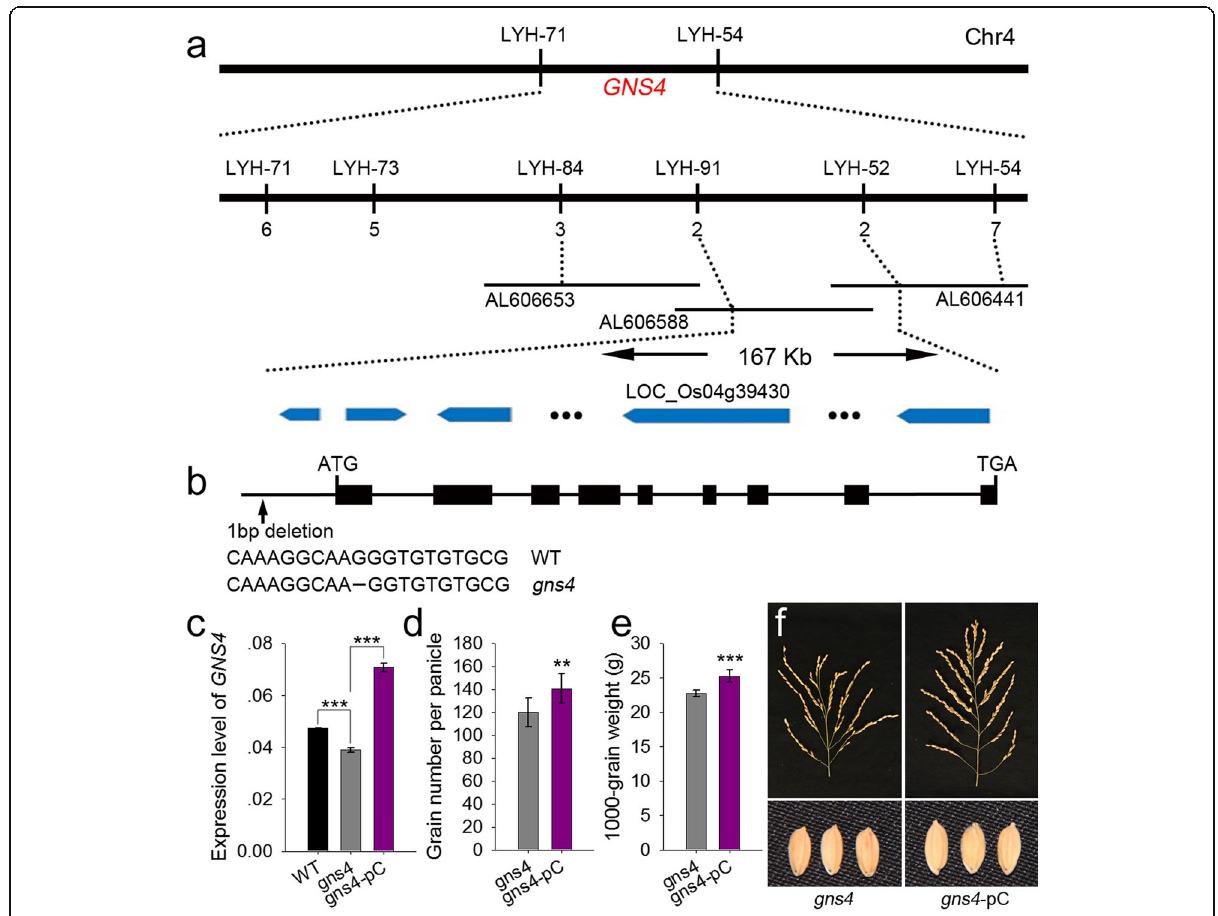
Fig. 2 Map-based cloning of GNS4 . a Fine mapping of GNS4 . GNS4 was primarily mapped between markers LYH-54 and LYH-71 on chromosome 4. Then, GNS4 was fine mapped into a 167-kb segment between markers LYH-52 and LYH-91, using 856 recessive plants from the segregating population. The numbers underneath each marker indicate the numbers of recombinants between GNS4 and the molecular markers. The candidate genes within this region were showed in blue. b Gene structure and the sequence variance of GNS4 between WT and the gns4 mutant. c The expression levels of GNS4 among WT, gns4 and the complementary transgenic plants. The expression level of the rice Actin gene was amplified as a control. Values are means ± s.e. of three independent experiments. d Comparison of grain number per panicle between gns4 mutant and complementary transgenic plants. Data are given as means ± s.e. ( n = 11). e Comparison of grain weight between gns4 mutant and complementary transgenic plants. Data are given as means ± s.e. ( n = 11). f Panicle and grain phenotypes of gns4 and complementary transgenic plants. gns4-pC presents the transgenic gns4 plants with pGNS4::GNS4 ZH11C construct. Significant at ***0.1% and